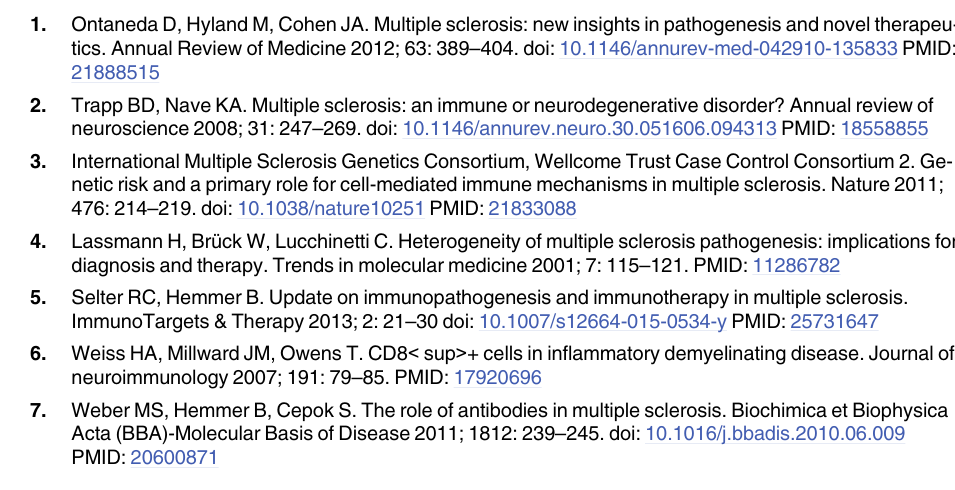
S1 Table. Random selection of the samples from the patient cohorts resulted with the mo- lecular pathways in each of clinical subtypes. Numbers indicate the counts of revealed path- ways in subtype. As expected Renin-angiotensin system and complement and coagulation cascades were revealed in each subtypes more than by chance. Prion disease also revealed in each disease subtypes. Aldosterone regulated sodium reabsorption pathway did not hit any of subtypes by random